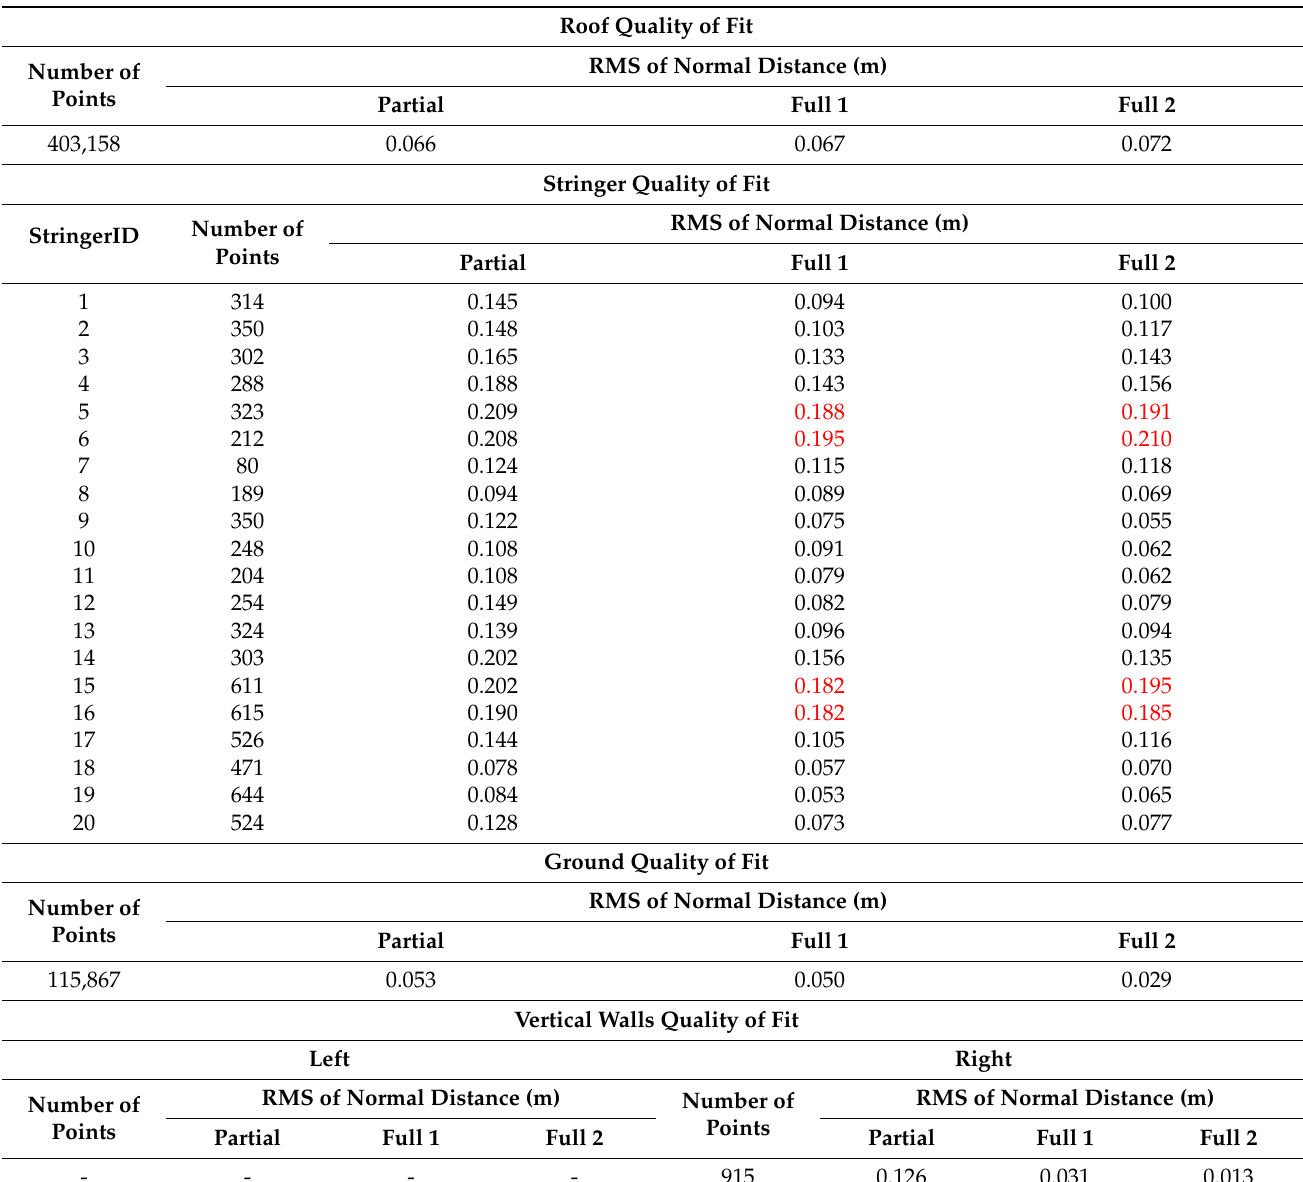
Table 6. RMS of the fitting error of the registration primitives in the West Lafayette dataset after partial fine registration using the roof feature, full fine registration using the roof/stringer features (Full 1), and full fine registration using the roof/stringer/ground/wall features (Full